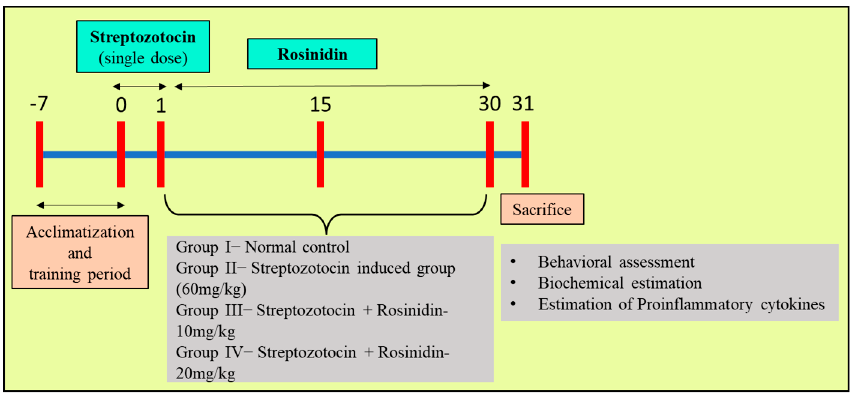
Figure 1. Experimental plan.